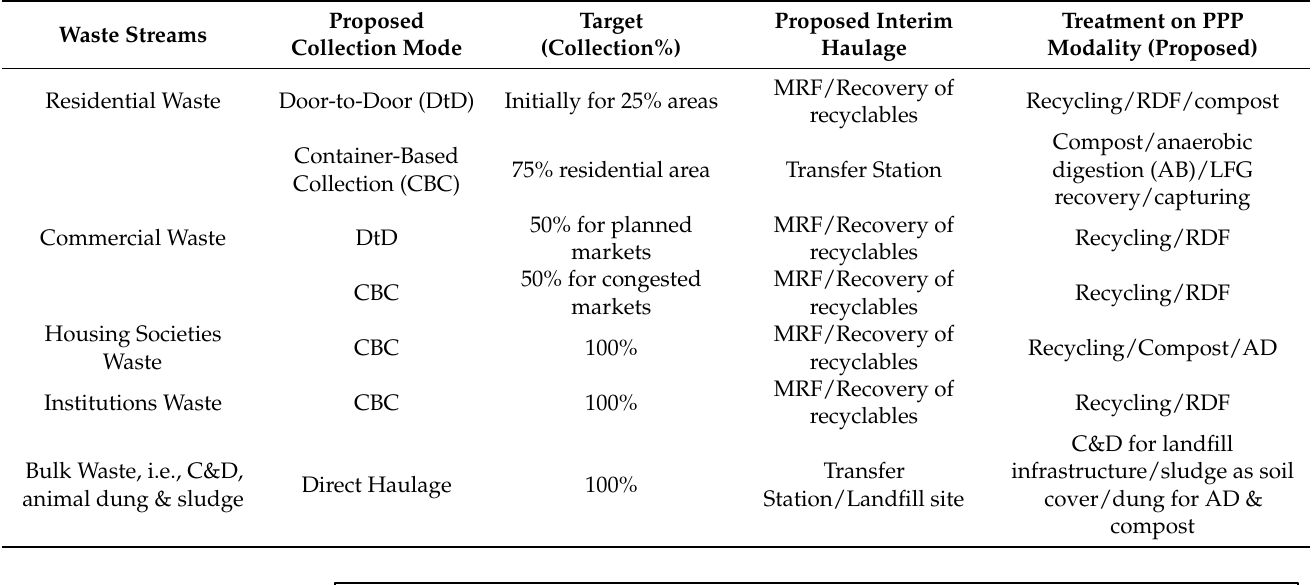
Table 4. Proposed technical interventions to sustain waste sector in Lahore.